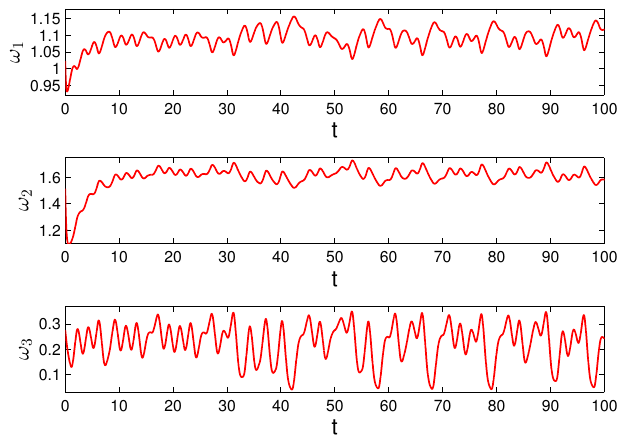
Figure 1. The coordinates of the function ω ( t ) , which exponentially converge to the coordinates of the unpredictable solution of Equation (23).